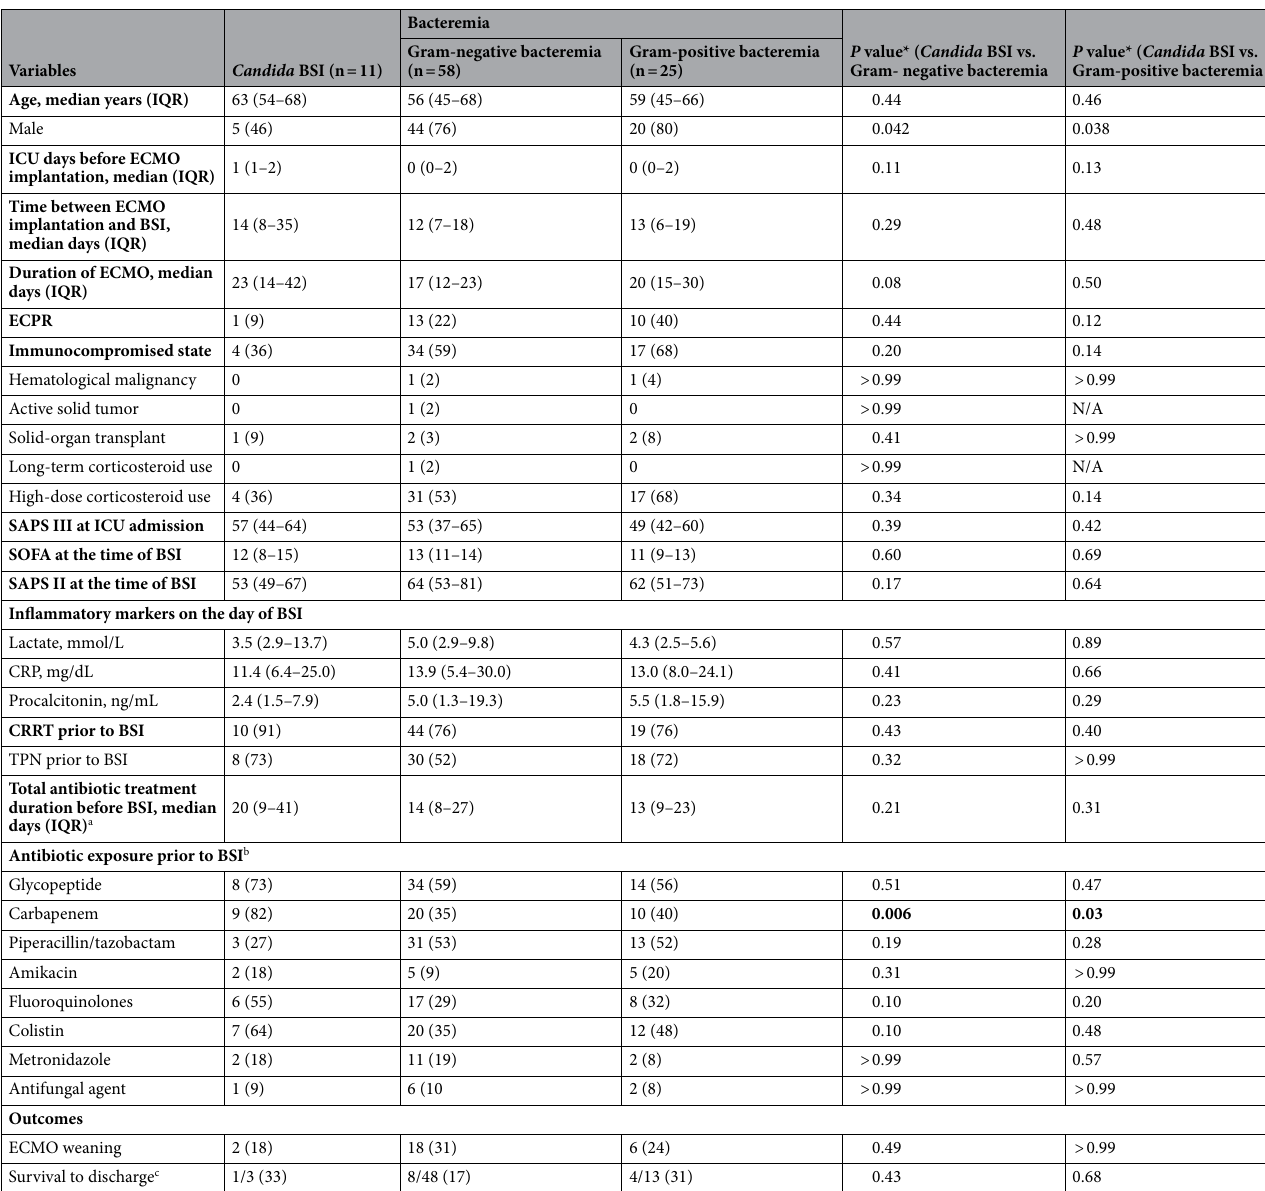
Table 3. Clinical characteristics and outcomes of the 11 cases of Candida BSI and 83 cases of bacteremia during venoarterial extracorporeal membrane oxygenation (VA ECMO). BSI, bloodstream infection; CRP, C-reactive protein; CRRT, continuous renal replacement therapy; ECPR, extracorporeal cardiopulmonary resuscitation; ICU, intensive care unit; IQR, interquartile range; SAPS, Simplified Acute Physiology Score; SOFA, sequential organ failure assessment; TPN, total parenteral nutrition. *P values with significant difference are indicated in bold. Data are presented as No. (%) unless indicated otherwise. a Total antibiotic treatment duration between hospital admission and BSI development. b > 48 h of therapy within the 14 days prior to